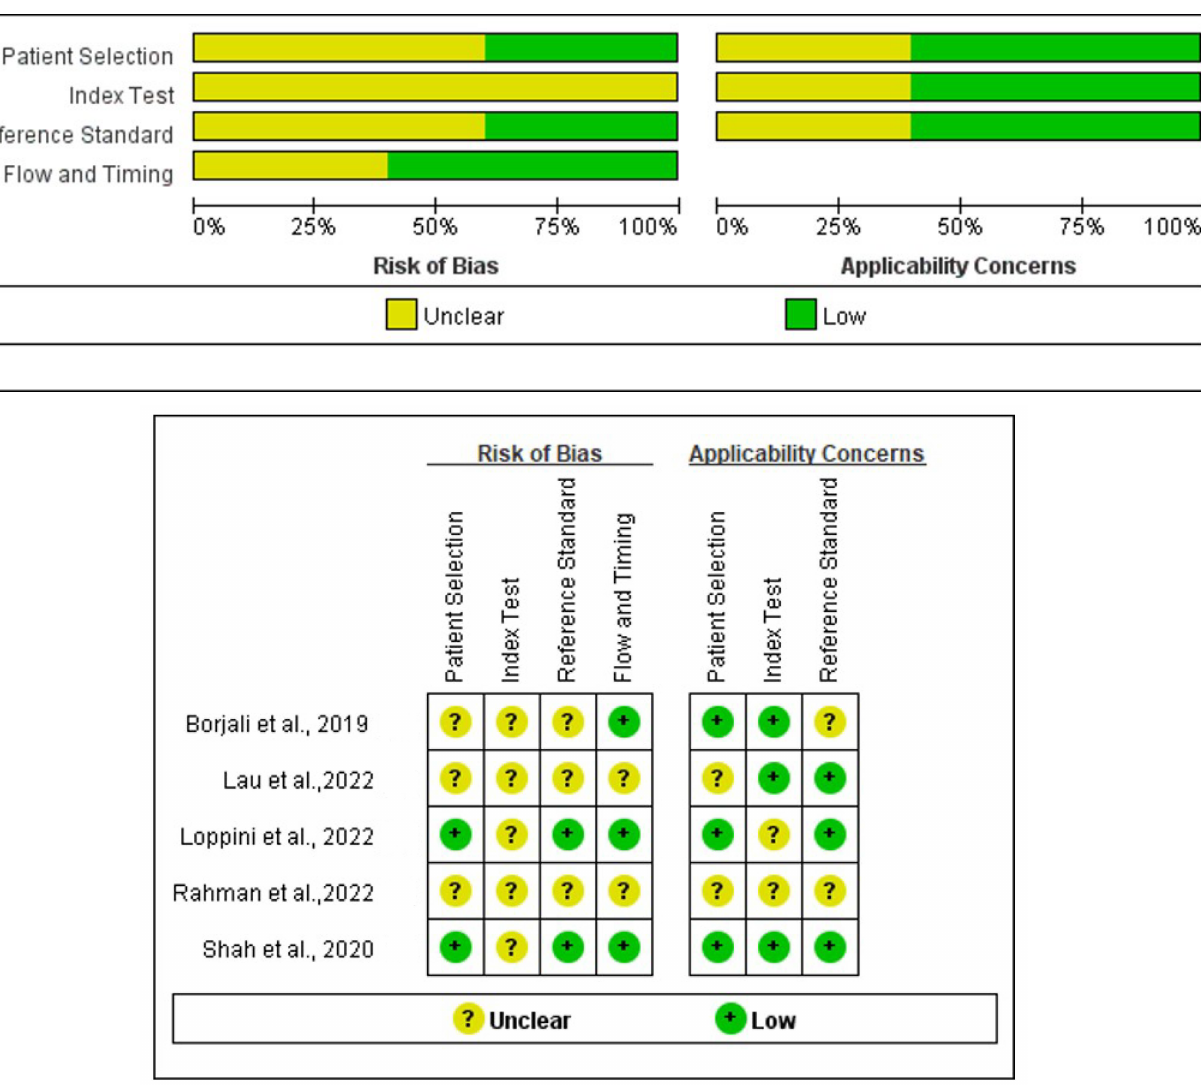
Figure 5. Methodological assessment by QUADAS-2 [32–36].